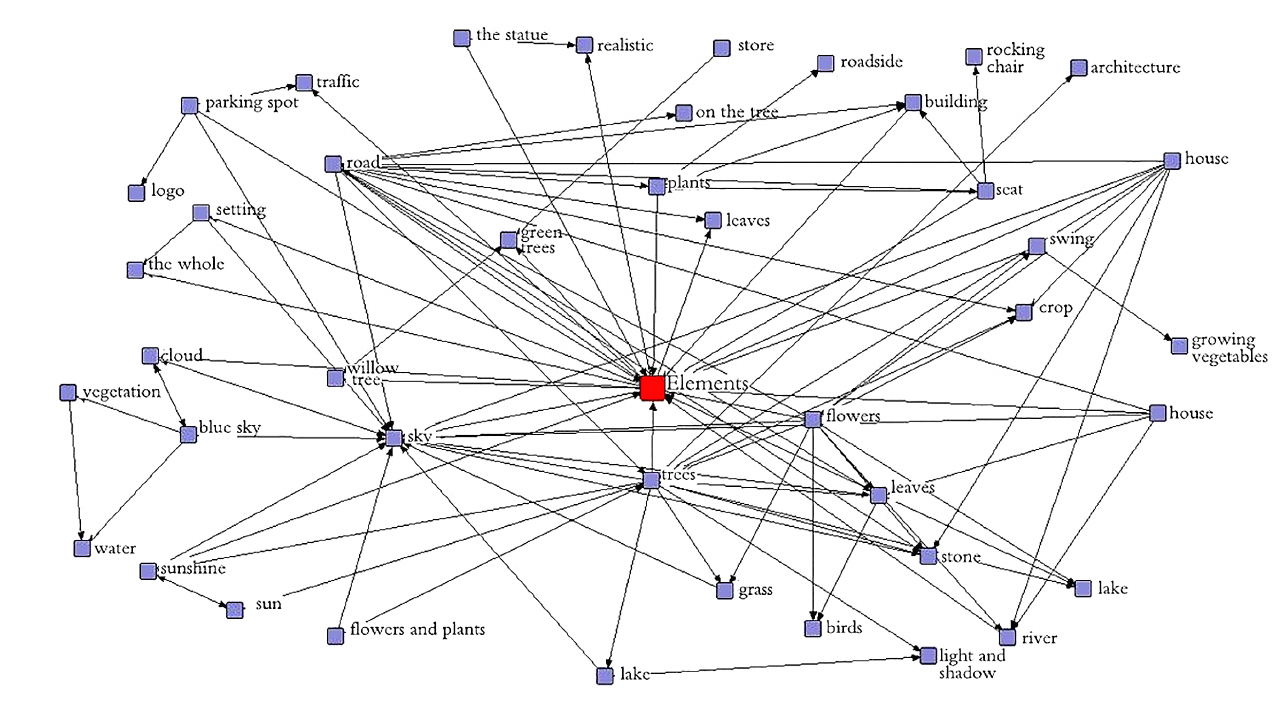
Figure A6. Semantic network analysis diagram of the elements of